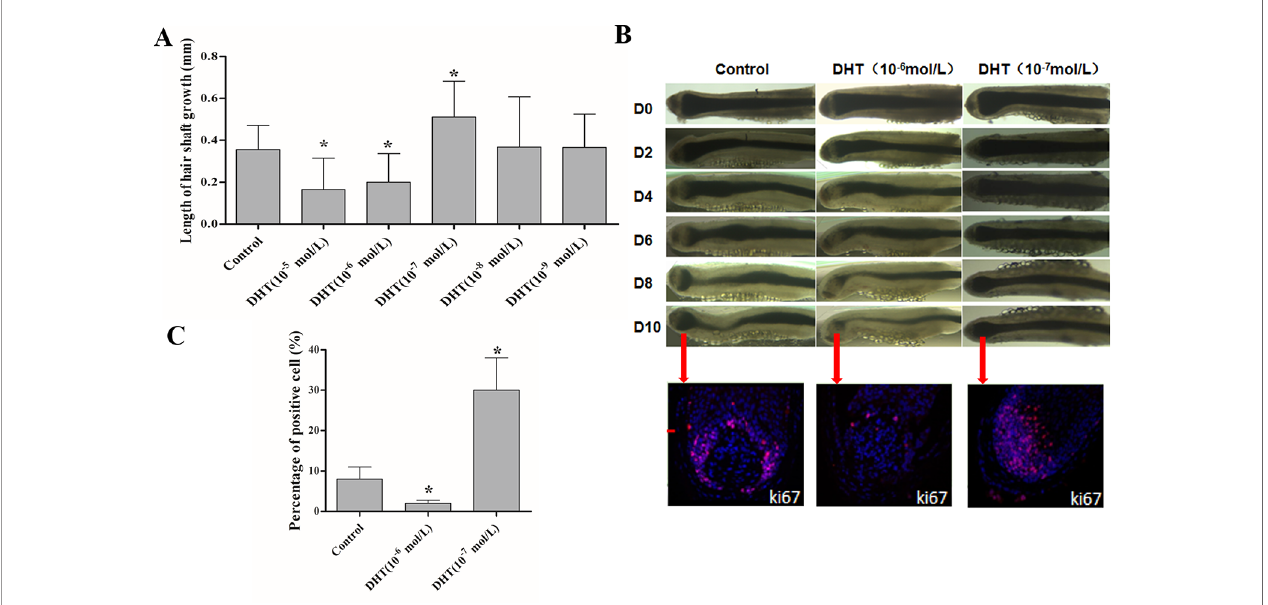
FIGURE 1 | Effects of different concentrations of dihydrotestosterone (DHT) on hair shaft growth of human HFs in vitro . Isolated anagen human HFs were cultured with DHT at various concentrations or vehicle for 10 days. (A) Mean growth rates of hair shafts. Hair shaft length was measured every 2 days (n = 18). (B) Changes in hair bulb morphology during the 10-day experimental period and immuno fl uorescence staining of Ki67 in HFs cultured with various concentrations of DHT (0, 10 -6 and 10 -7 mol/L) at day 10. (C) Percentages of Ki-67-positive cells in the matrix area (n = 6). The data are presented as the mean ± SD. Each bar represents the mean of three independent experiments performed in triplicate. Compared with the vehicle-treated control group, * P < 0.05.